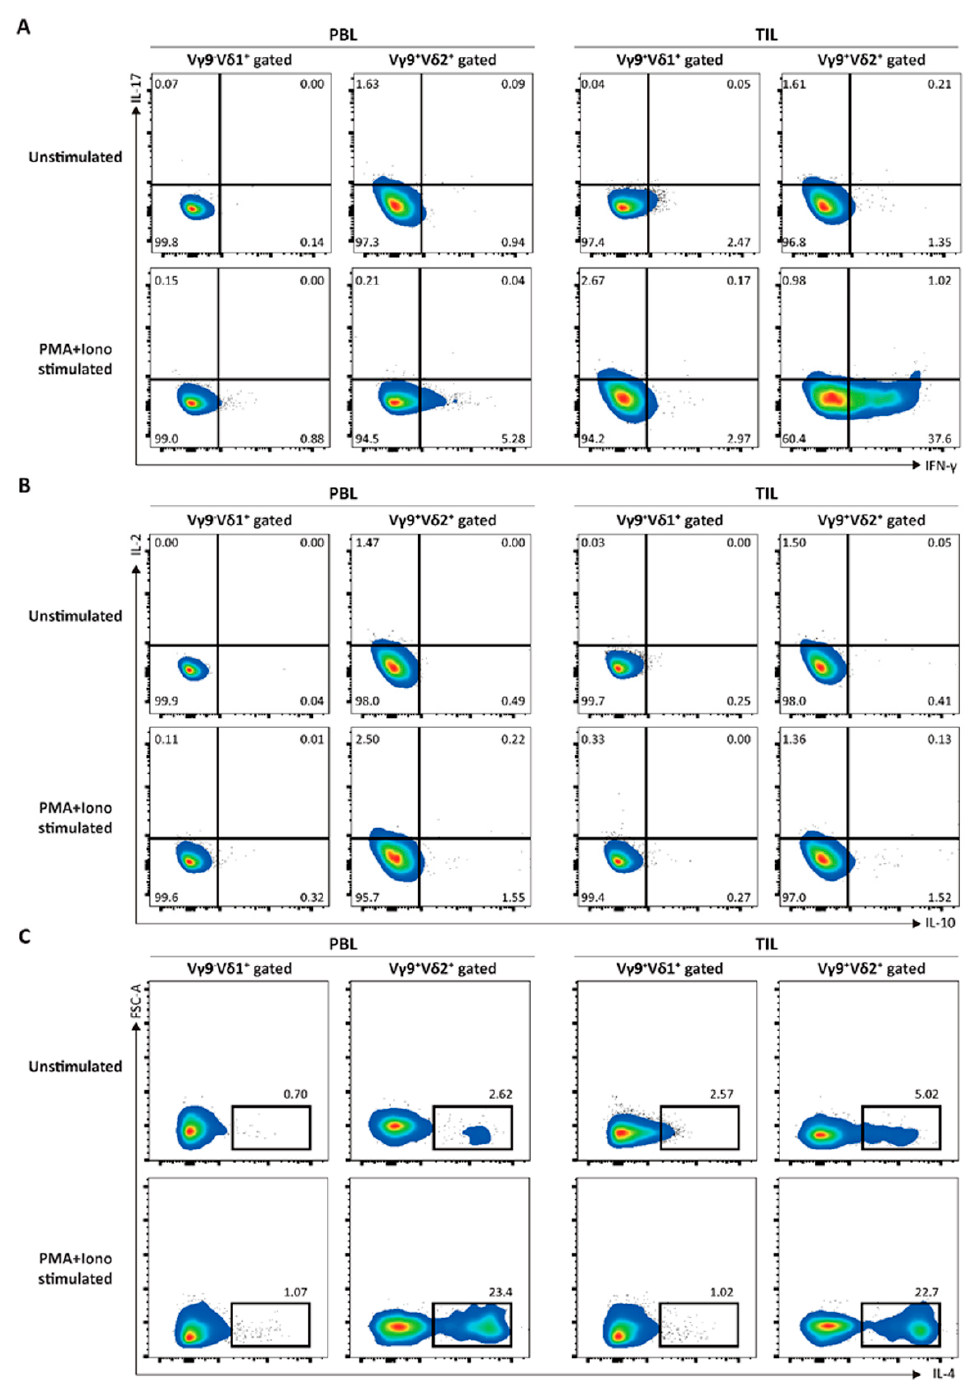
Figure 5. Cytokine secretion by V γ 9+- δ 1+ or V γ 9+- δ 2+ cells. Lymphocytes from peripheral blood (PBL) or tumor (TIL) stimulated with or without phorbol myristate acetate (PMA) and ionomycin for 4 hours were stained with Abs against indicated cytokines; ( A ) IL-17 and IFN- γ , ( B ) IL-2 and IL-10, and ( C ) IL-4. The cytokine expression was shown for the gated V γ 9+- δ 1+ or V γ 9+- δ 2+ cells.